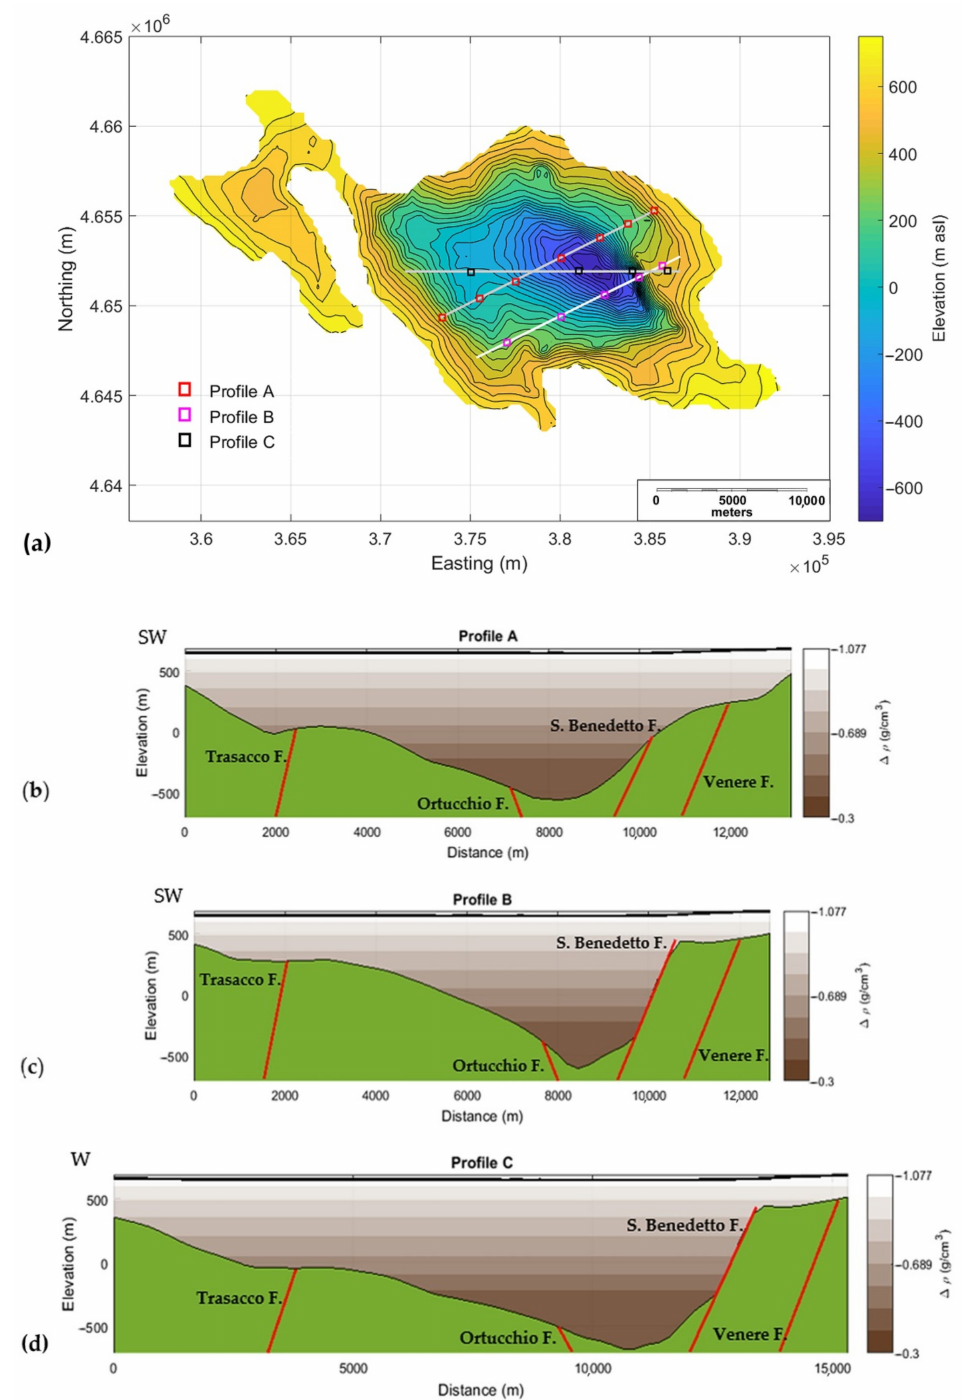
Figure 12. Sections through the basement model. ( a ) Basement map with the location of the sections (white lines) and of the maxima of the EHD as identified in Figure 3 (colored squares); ( b ) Profile A; ( c ) Profile B; ( d ) Profile C. Red lines are the inferred faults located on the base of the EHD analysis (Figure 3). Brown shading represents the density contrast variation with depth estimated in the ITRESC